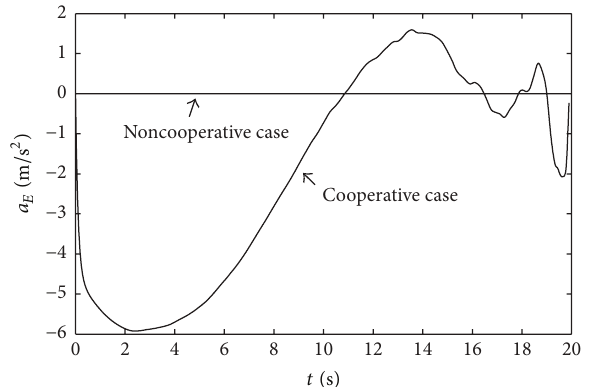
Figure 14: The Evader acceleration considering HP guidance Pursuer.